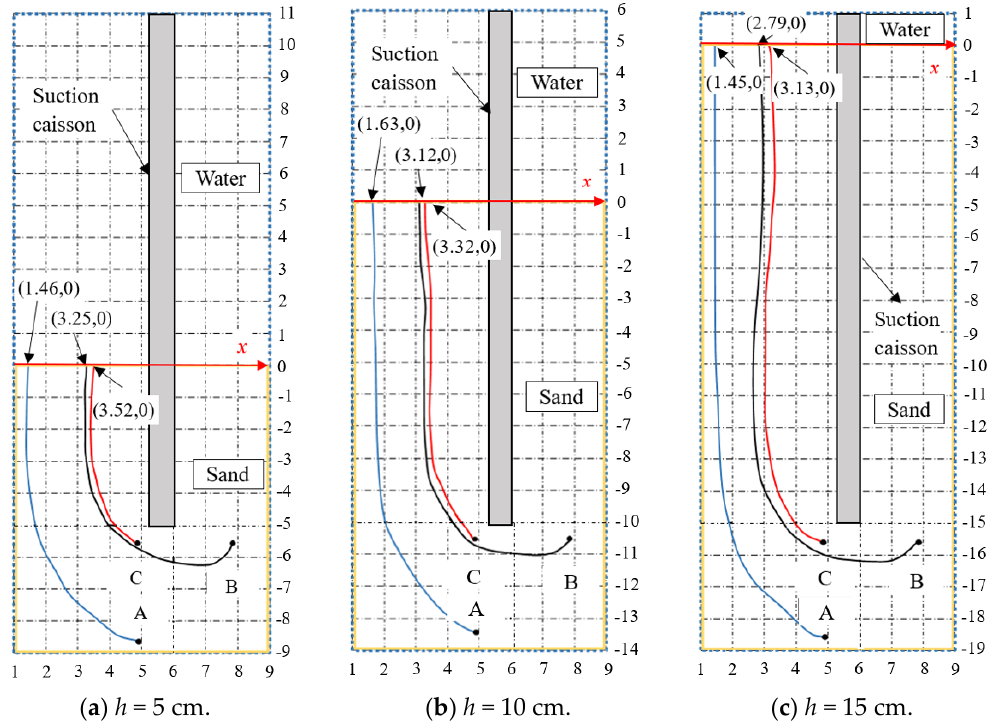
Figure 4. The seepage path of the carmine stain in sand.